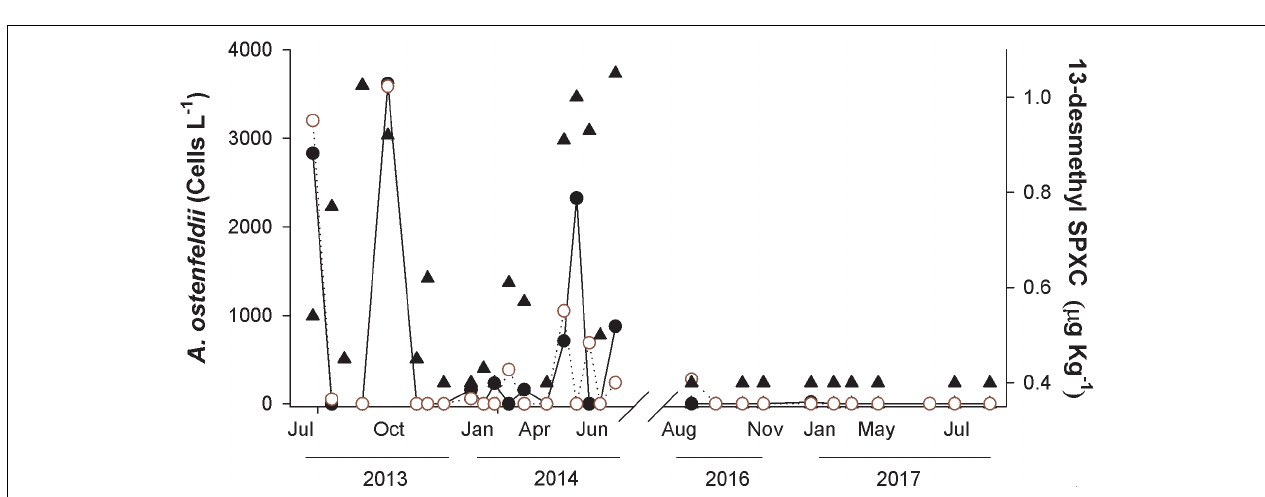
FIGURE 6 | LC-MS/MS chromatograms (in MRM mode) of 13-desmethyl spirolide (SPX) C transitions (692.501 > 164 m/z and 692.501 > 444.30 m/z ). Mass transitions of 13-19-didesmethyl spirolide (SPX) C and spirolide (SPX) B are also shown but were not detected in this sample of Mediterranean mussels ( M. galloprovincialis ) from TSB collected on September 12, 2014.